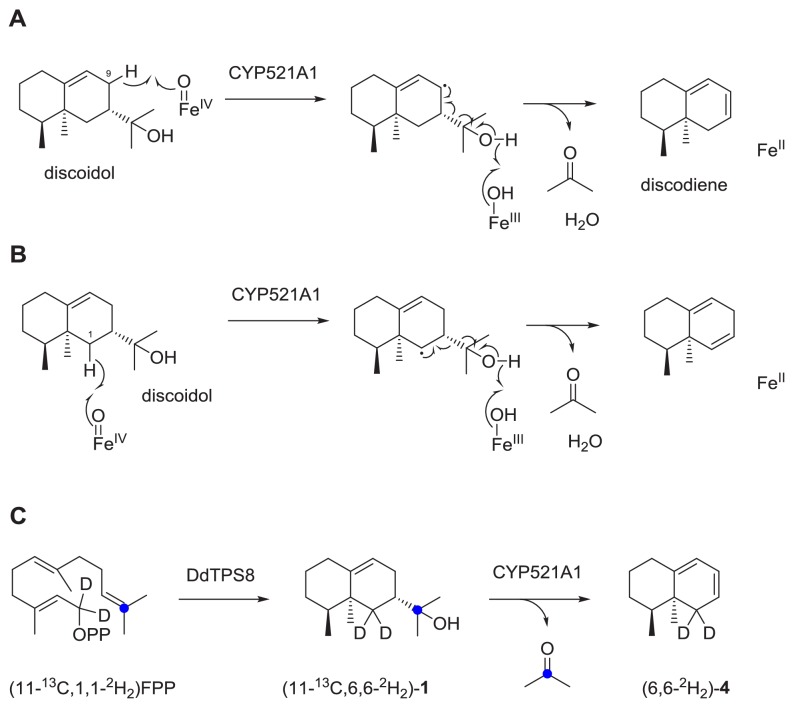
Formation of discodiene by CYP521A1.